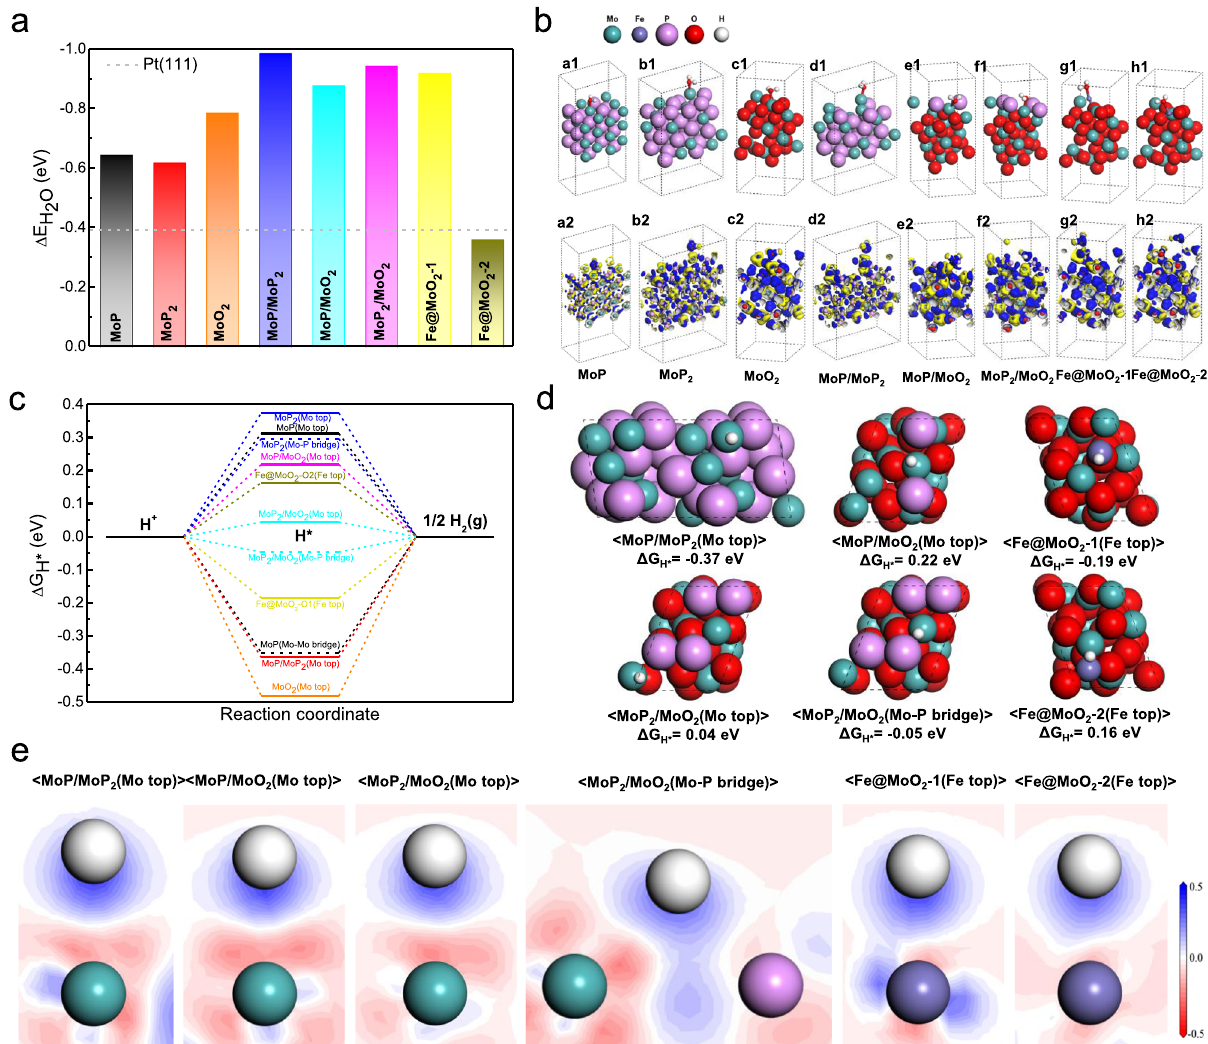
Fig.5|DFTsimulationsofFe/SAs@Mo-based-HNSsdesignedtocatalyseHERin alkaline conditions. a DFT-calculated Δ E H2O on various exposed surfaces of MoP, MoP 2 , MoO 2 , MoP/MoP 2 , MoP/MoO 2 , MoP 2 /MoO 2 , Fe@MoO 2 − 1, and Fe@MoO 2 − 2, respectively. As a reference, the Δ E H2O of the Pt(111) surface is marked by the grey dashed line. b DFT-optimised atomic con fi gurations and corresponding electron density differences for MoP (a1 and a2), MoP 2 (b1 and b2), MoO 2 (c1 and c2), MoP/ MoP 2 (d1 and d2), MoP/MoO 2 (e1 and e2), MoP 2 /MoO 2 (f1 and f2), Fe@MoO 2 − 1 (g1 and g2), and Fe@MoO 2 − 2 (h1 and h2), after H 2 O adsorption at their surface sites. Yellowisosurfacesandblueisosurfacesrepresentthedepletionandsegregationof